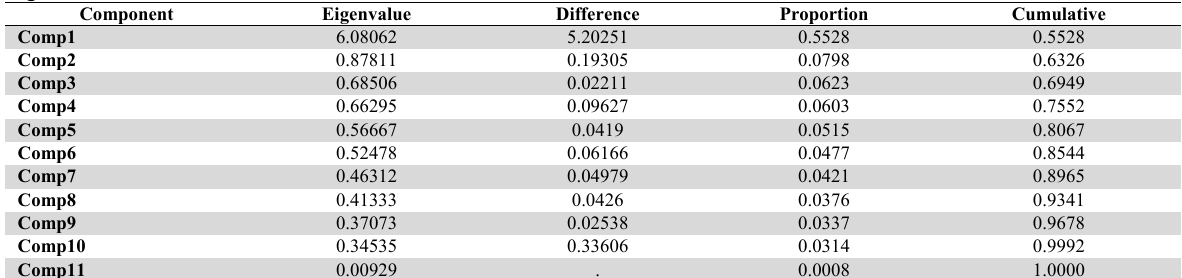
Eigenvalues of the correlation matrix